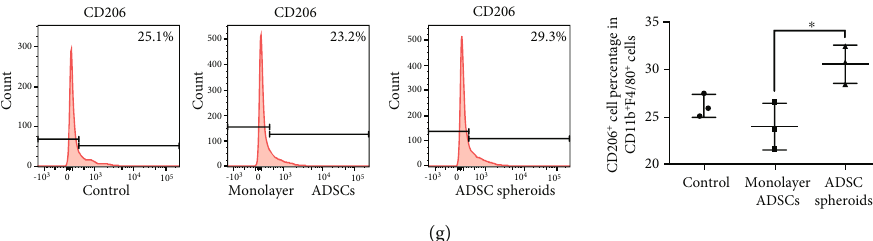
Figure 6: Therapeutic potential of ADSC spheroids in a mouse model of LPS-induced endotoxemia. (a) Survival rates of mice with LPS- induced endotoxemia following monolayer ADSCs and ADSC spheroid treatment within 48 h. Administration dosage of LPS was 25mg/kg ( n = 5 mice/group) and 50 mg/kg ( n = 10 mice/group). (b) Cytokine levels were determined by ELISA in protein extracts from blood serum collected at 6 hours after LPS injection (50 mg/kg, n = 3 -5 mice/group). ∗ P < 0 : 05 vs. the control group. (c) Gating strategy for identi fi cation of Tregs with fl ow cytometry. (d) The percentages of CD4 + CD25 + Foxp3 + cells in the CD4 population of splenocytes isolated at 6h after LPS injection (50 mg/kg, n = 3 mice/group). (e) Gating strategy for identi fi cation of macrophages with fl ow cytometry. (f, g) The percentages of CD86 + (M1 macrophage biomarker) or CD206 + (M2 macrophage biomarker) cells in CD11b + F4/80 + population (total macrophages) of splenocytes isolated at 6h after LPS injection (50 mg/kg, n = 3 mice/group). ∗ P < 0 : 05 vs. the monolayer ADSC